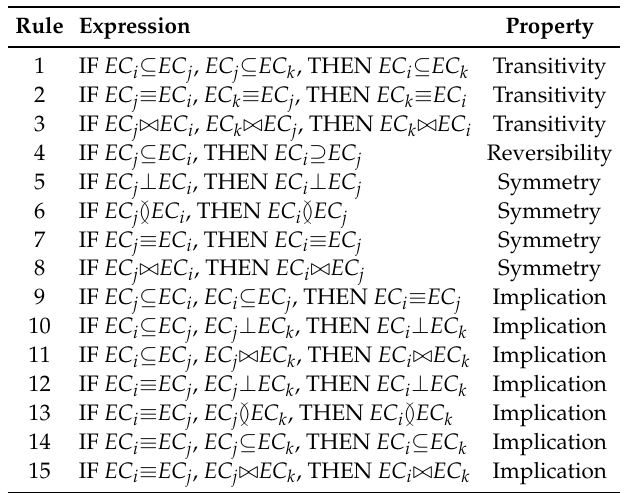
Table 2. Reasoning rules based on the relationships among entity classes.